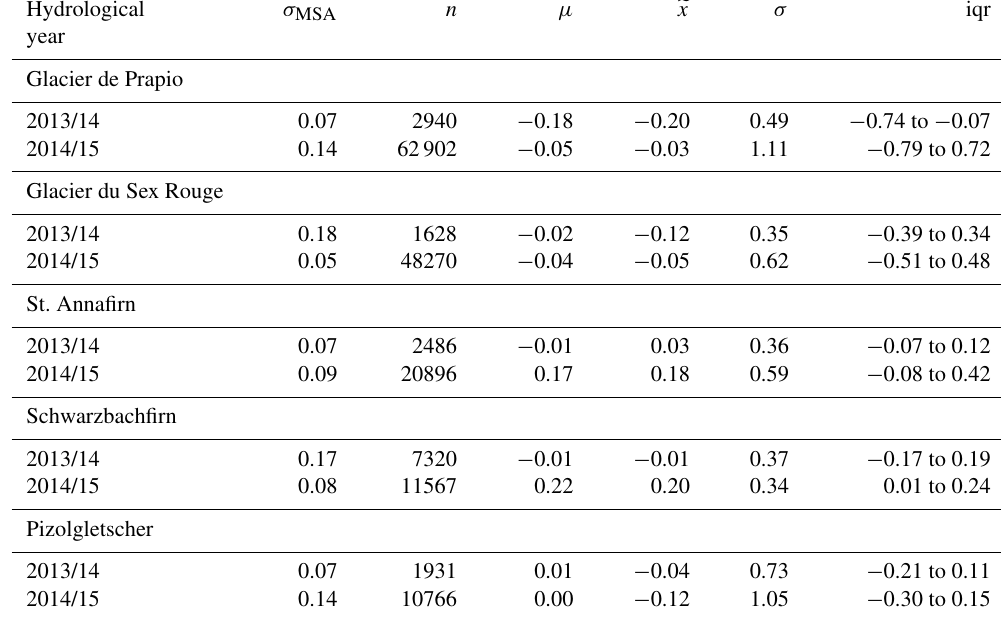
Table 3. Limits of detection for the TLS-derived surface elevation changes ( σ MSA ) and number of points used for the Multi-Station Adjust- ment fine registration of consecutive point clouds ( n ) for both observation periods and the surveyed Glacier de Prapio, Glacier du Sex Rouge, St. Annafirn, Schwarzbachfirn, and Pizolgletscher. In addition, the mean ( µ ), median ( e x ), standard deviation ( σ ) and interquartile range (iqr) of elevation differences from the comparison of TLS-derived annual surface elevation changes over stable terrain (all in m) are given. Hydrological σ MSA